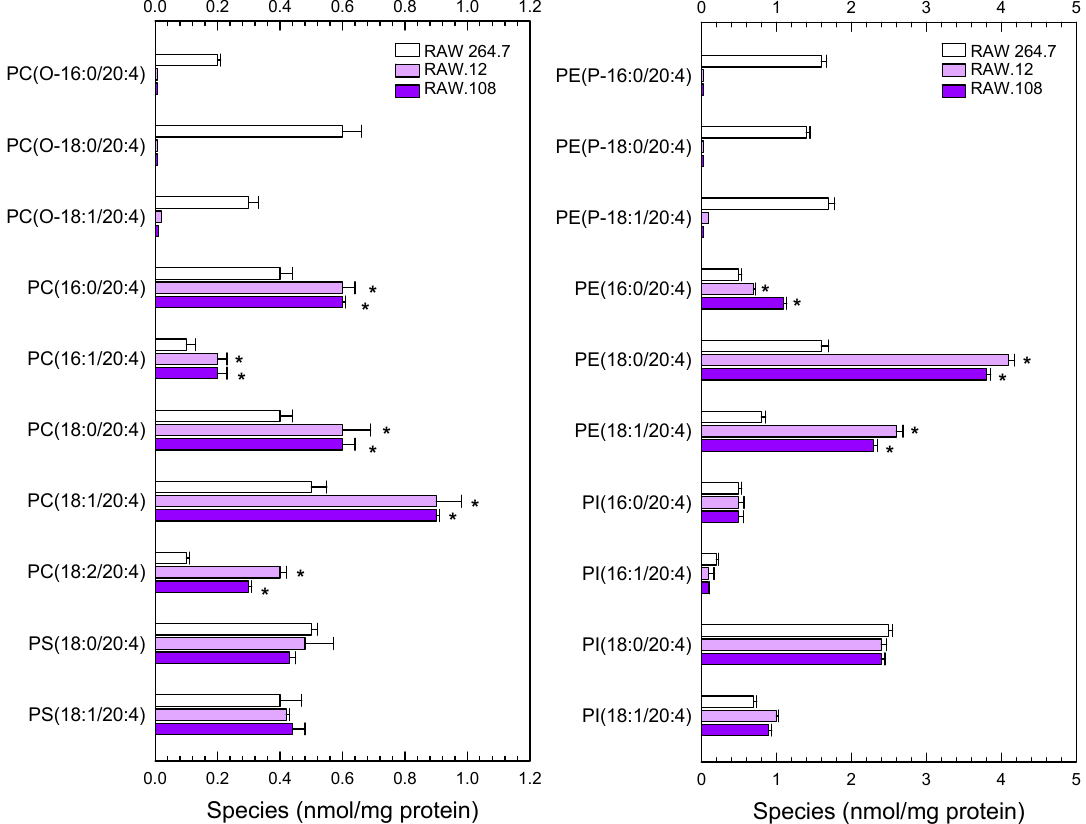
Figure 2. AA-containing phospholipid species in RAW 264.7 cells and plasmalogen-deficient variants: The profile of AA-containing PC, PS (left panel), PE, PI (right panel) was determined for RAW 264.7 cells (open bars), RAW.12 cells (light purple bars), and RAW.108 cells (dark purple bars) by LC/MS. Results are shown as means ± S.E.M. (n = 3). * p < 0.05, significantly different from the corresponding species of RAW264.7 cells.